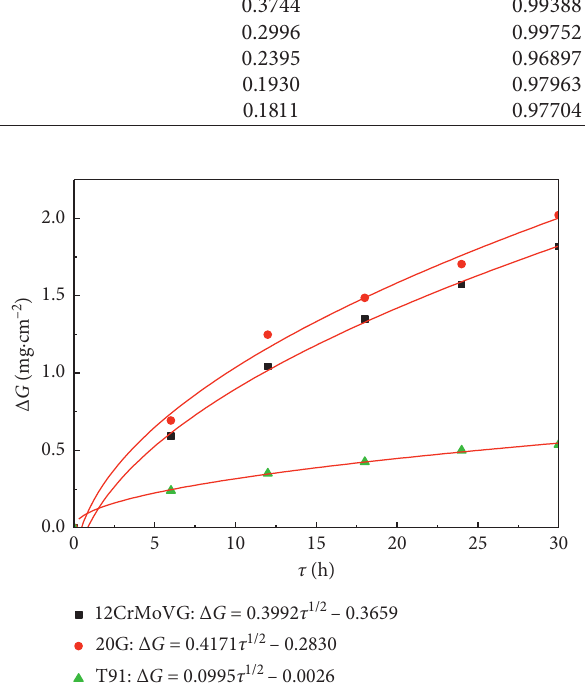
Figure 3: Curves and fitting correlations of corrosion mass gain of metal samples coated with ash.